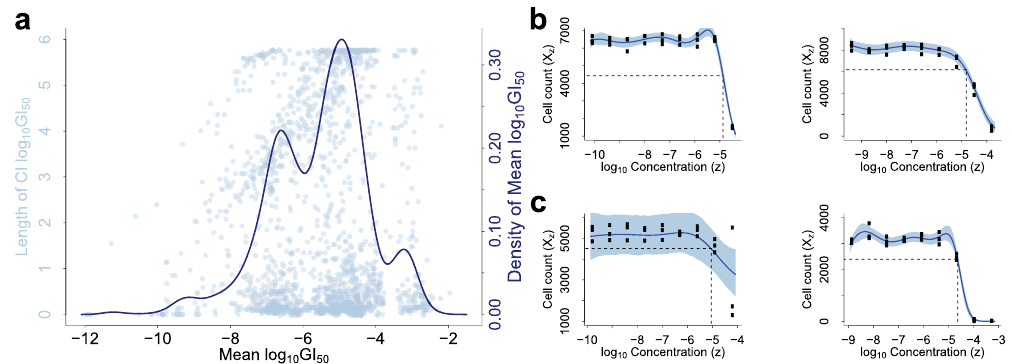
Figure 4. ( a ) Length of the credible interval of log 10 GI 50 v.s. mean of log 10 GI 50 ; distribution of mean log 10 GI 50 . ( b,c ) Dose-response modeling of cell line 21NT treated with compounds Nelfinavir and 4-HC ( b ), and cell line MDAMB415 treated with compounds Disulfiram and Imatinib ( c ). Curves and shades in ( b,c ) represent the posterior means and the 95% credible intervals of the Kendall Process means, respectively. Dashed lines are the log 10 GI 50 ’s calculated from the mean estimations of Kendall Process